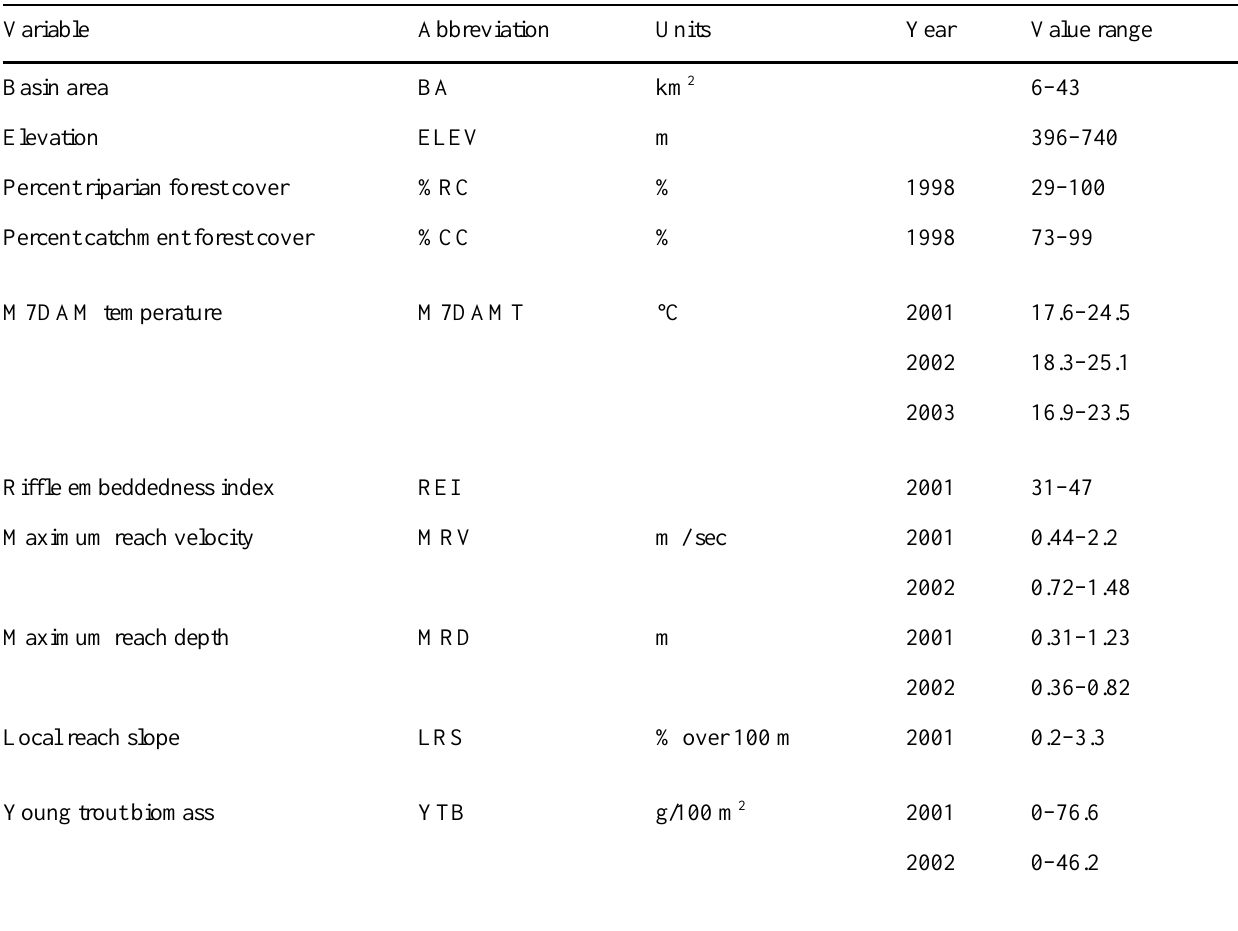
Table 3. Landscape, aquatic habitat, and trout variables measured for primary sampling sites ( n = 28). In 2002, we resampled velocity and depth conditions and trout at ten